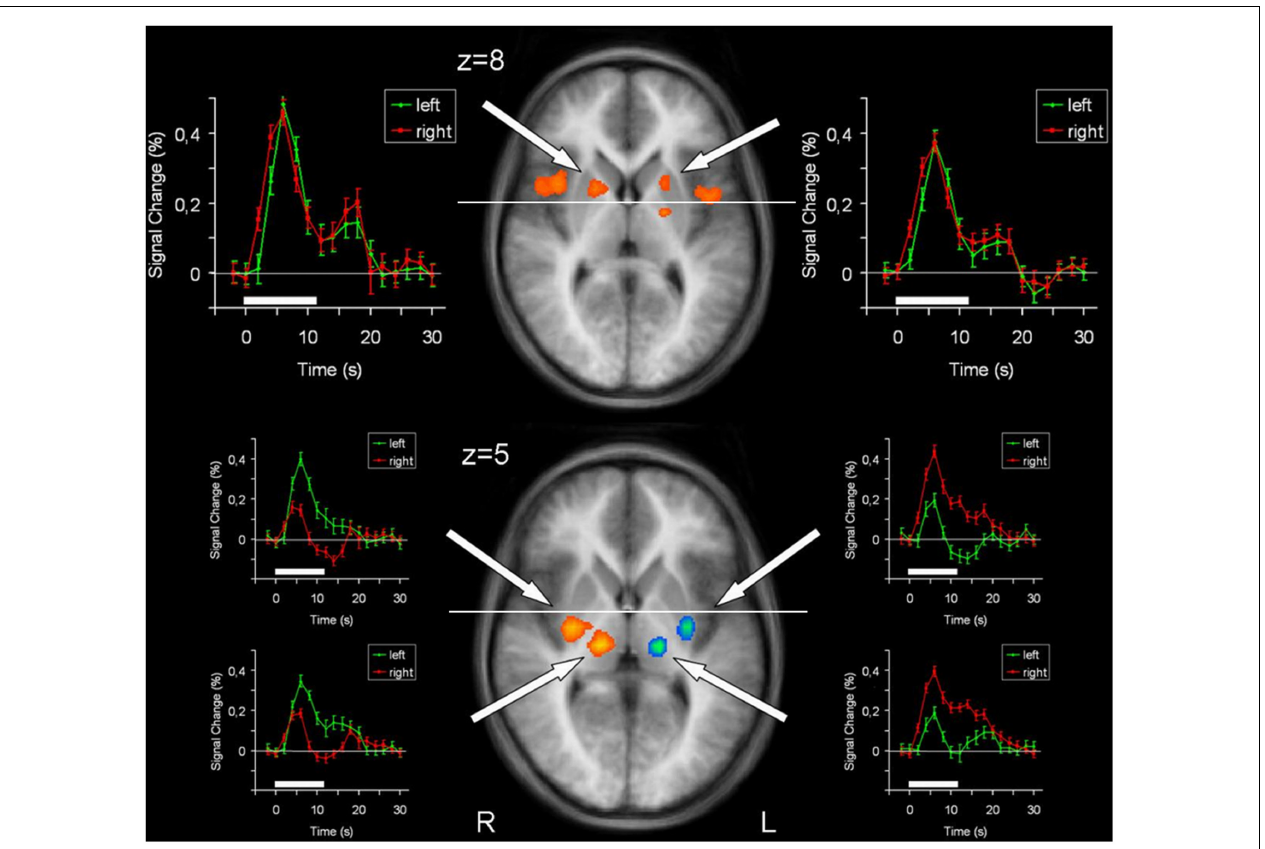
putamen, caudal putamen, and thalamus, for left hand (green) and right hand (red) finger tapping. The white bars indicate the interval of the movement condition. The white line indicates the level of the VAC-line ( y = 0). p < 0.001; corrected for multiple comparisons. L, left; R, right. The Talairach coordinate in millimeter is indicated.